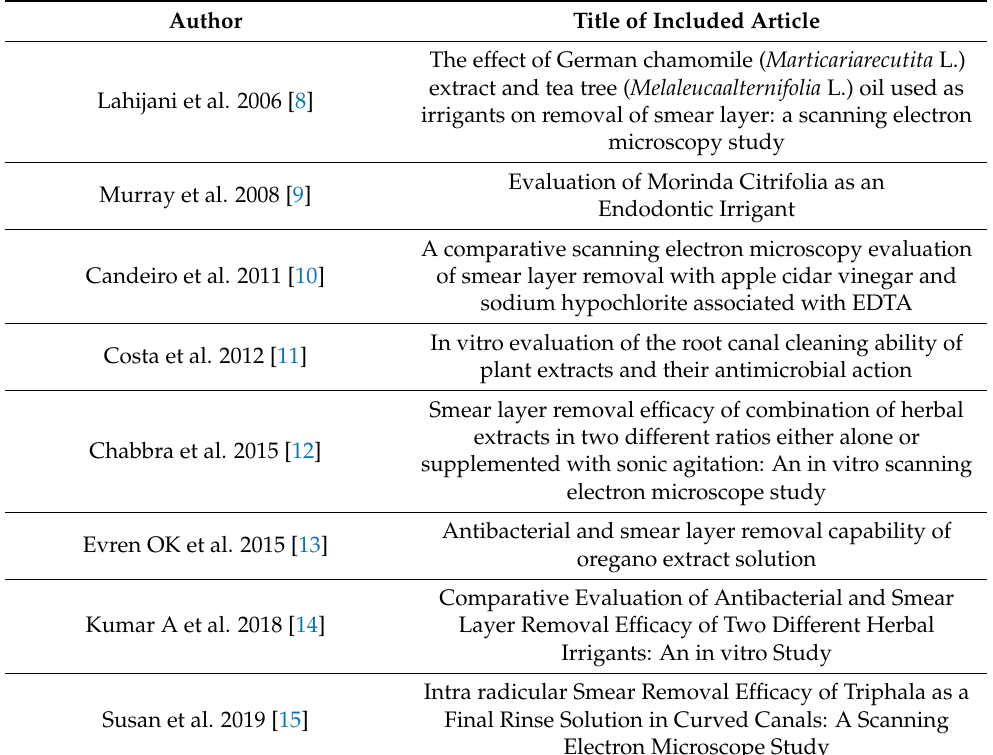
Table 2. List of included articles.